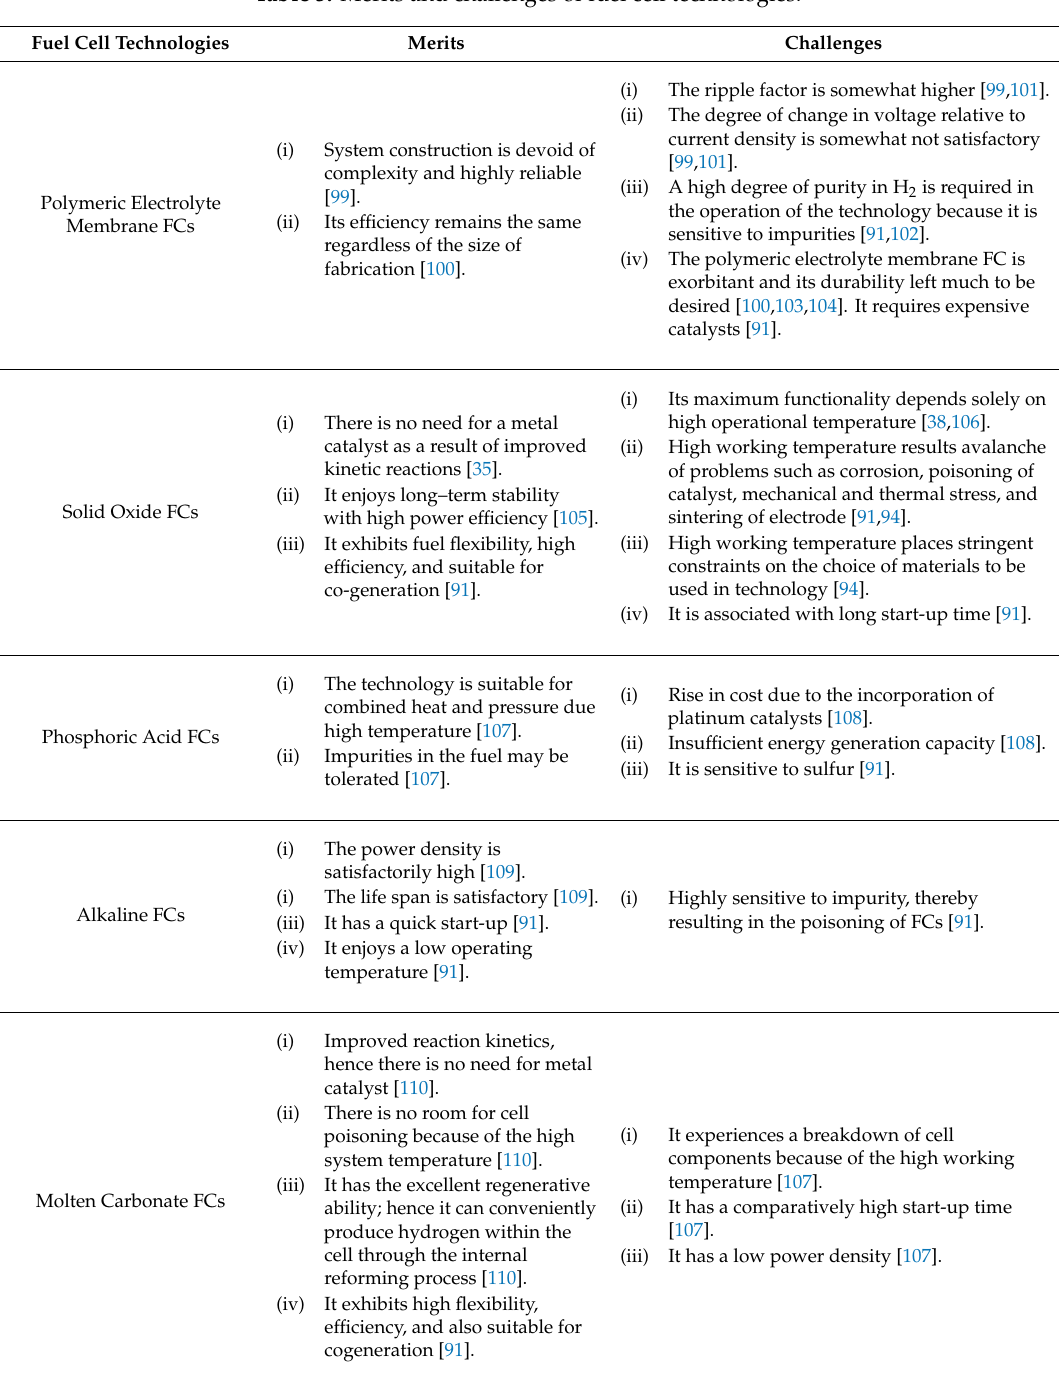
Table 3. Merits and challenges of fuel cell